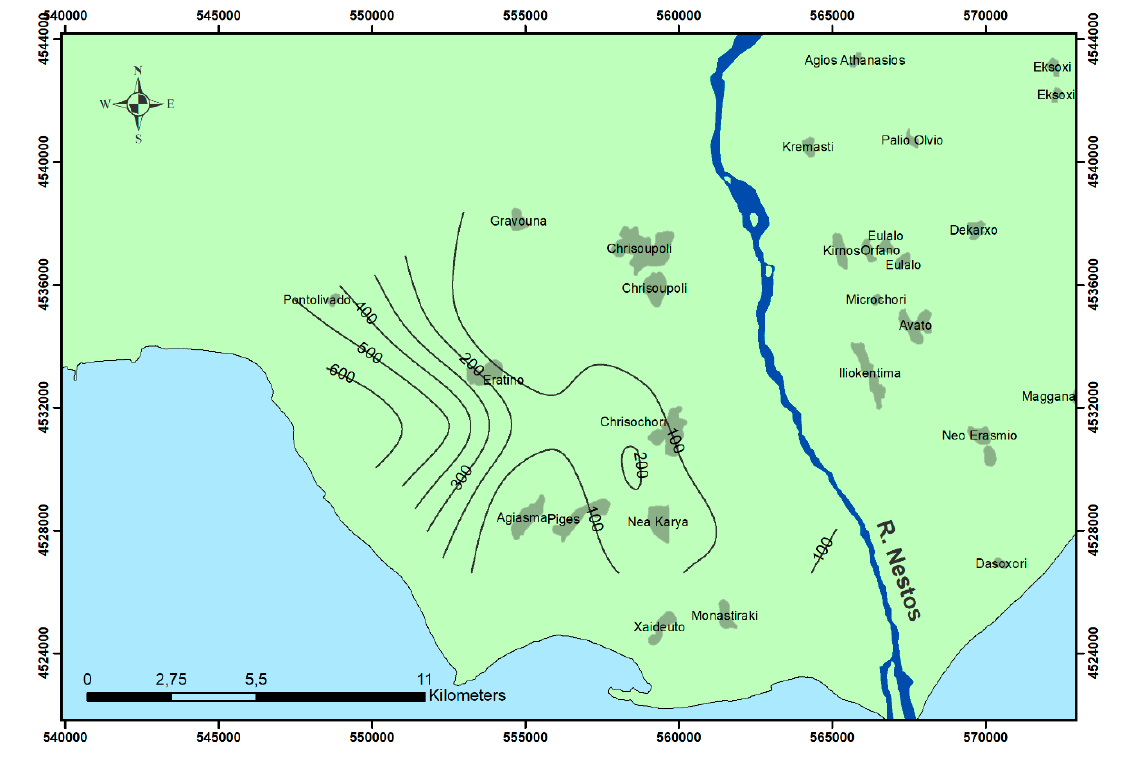
Figure 15. Chloride ion (Cl − ) distribution map (mg/L) of the confined aquifer (May 2019).